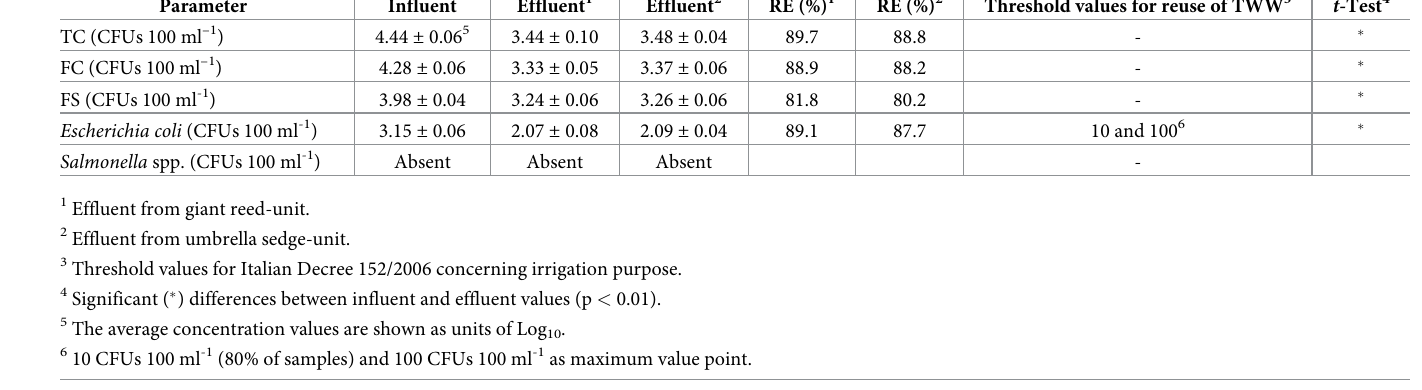
Table 3. Main microbiological composition of the treated wastewater from inlet to outlet of the HSSFs CW. Removal efficiency (RE) from April to September 2016/ 2018. For each unit, three-year average values ( ± standard deviation) are shown (n = 36).